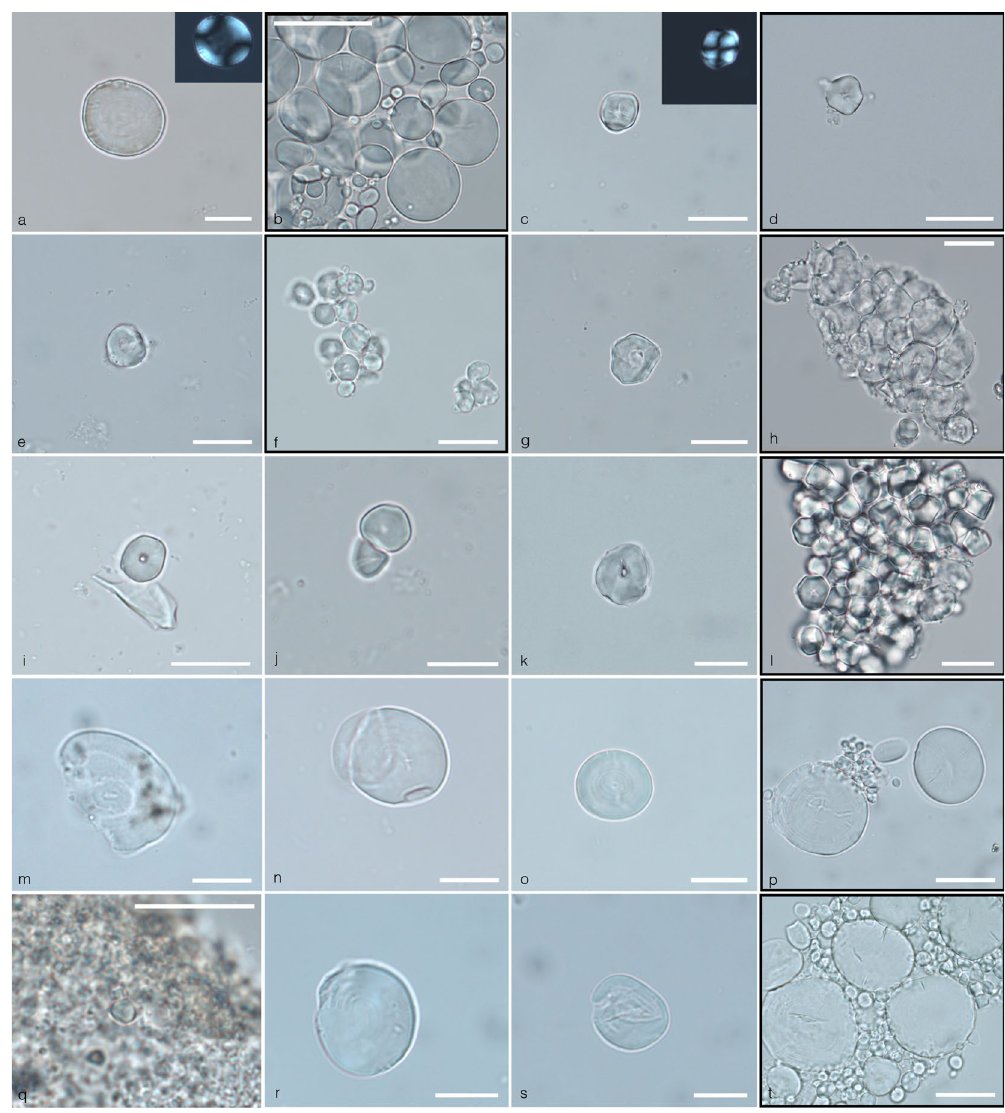
Figure 6. Archaeological starch granules identified in Grotta Continenza individuals and experimental reference (black-framed photos). ( a ) Starch granule from GC33 (Sauveterrian); ( b ) Large circular starch grains of Aegilops geniculate characterized by mesial lamellae; ( c ) Starch granule from GC 28 (Sauveterrian); ( d ) Single polyhedral starch granule of Setaria ventricolata characterized by a central depressed hilum, fissures and no lamellae; ( e ) Starch granule from GC36 (Sauveterrian); ( f ) Polyhedral and circular starch granules of Echinocloa crussgalli characterized by a central depressed hilum and no lamellae ; ( g ) Starch granule from GC36 (Sauveterrian); ( h ) Polyhedral starch granules of Foxtail millet ( Setaria italica ) processed with a ground stone tool, characterized by a central depressed hilum and no lamellae. Notice the presence of intact, lumps of damaged starch granules with hilum enlarged and depressed after processing; ( i , j ) Starch granule from GC36 (Sauveterrian); ( k ) Starch granule from GC14 (Sauveterrian); ( l ) Lump of polyhedral starch granules of Foxtail millet ( Setaria italica ); ( m – o ) Starch granules from GC44 (Neolithic); ( p , s ) Circular starch granules of modern Triticum monococcum showing a bimodal distribution; ( q ) Starch granule from GC44 (Neolithic); ( r ) Starch granule from the calculus deposit of GC44 (Neolithic); ( t ) Starch granule from the calculus deposit of GC44